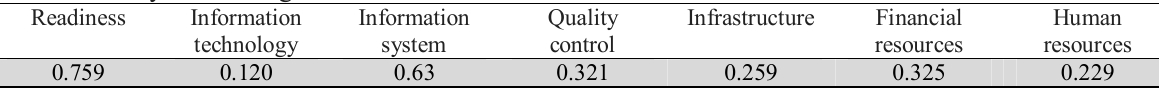
The summary of Kolmogorov-Smirnov